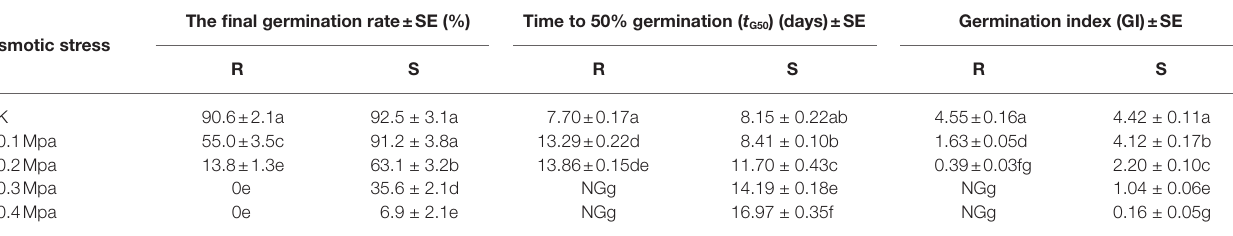
TABLE 2 | Effect of osmotic stress on the final germination rate, time to 50% germination ( t G50 ), and germination index (GI) of Polypogon fugax .